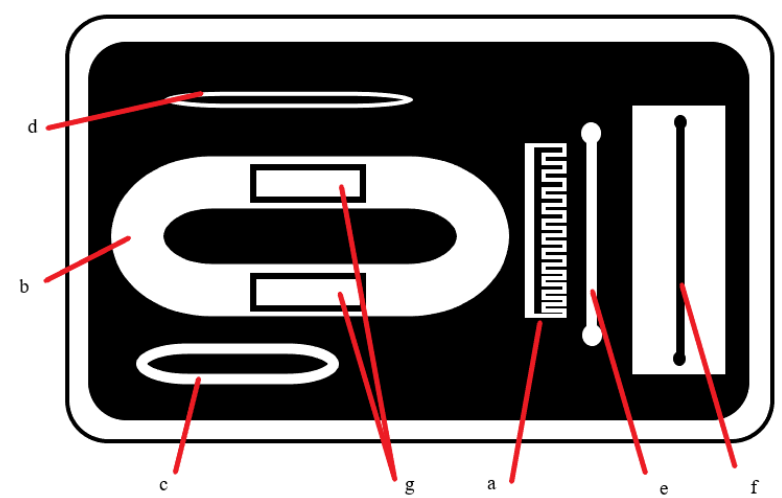
Figure 5. A sketch of the Biovotion Multi-Sensor arm-band, showing the various electromagnetic sensors (some of the sensors described in the text, including the humidity sensor and accelerometer, are within the housing and not visible in this image), based on a drawing from a recent patent document [74]: (a) inter-digital electrode operating in 1–20 kHz band as a sweat sensor; (b) ‘short’, (c) middle and (d) ‘long’ MHz-band electrodes; (e) ‘short’ and (f) ‘long’ GHz electrodes; (g) optical reflection sensors consisting of light sources and detectors. (Not to scale; geometries have been simplified)